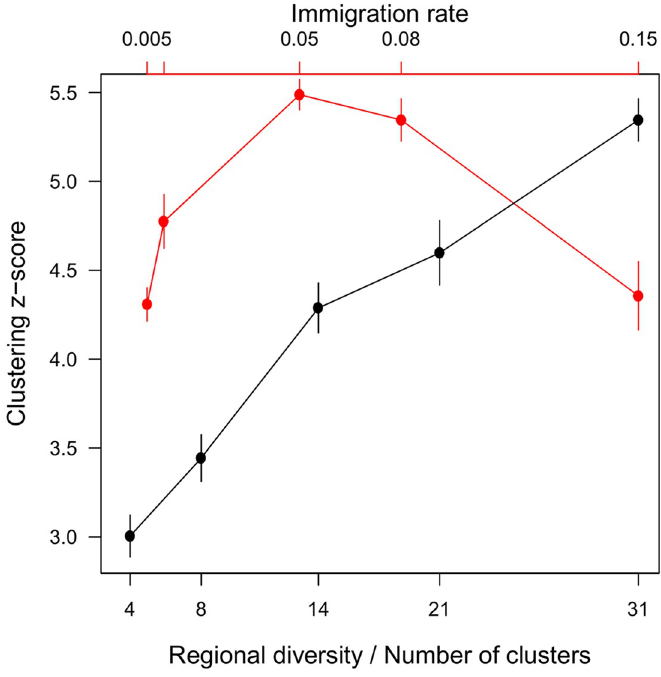
Fig 4. Impact of immigration and regional diversity. Clustering increases with regional diversity (black), and has a modal relationship with immigration pressure (red). Bottom axis: number of species in the pool divided by the number of clusters in the community. Top axis: immigration rate. Points show the mean z-score of the Ripley’s K metric across 10 replicates. Error bars show 1.96 standard errors of the mean. ( m = 0.08 when varying regional diversity, and the latter is fixed at c. 400 regional species when varying